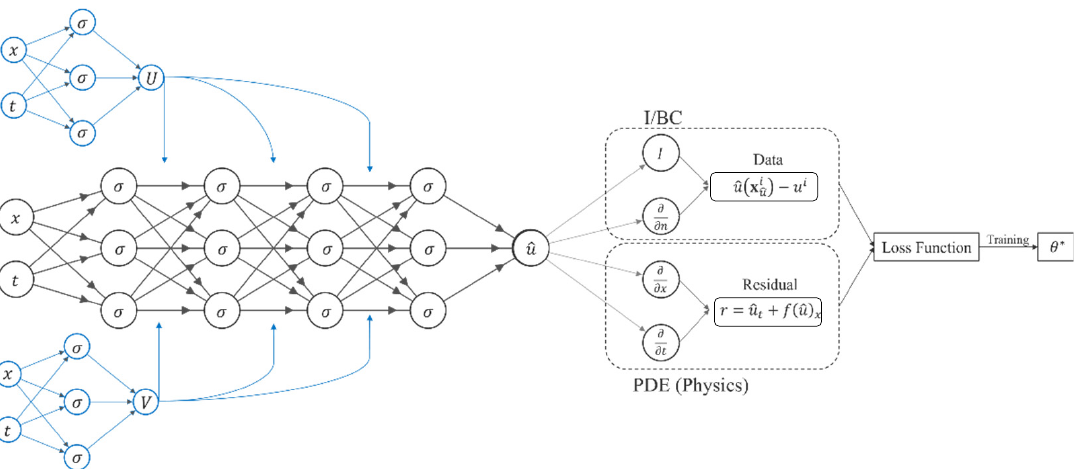
Figure 3. A representative PINN architecture for the solution of the hyperbolic Buckley–Leverett problem. In black is the MLP architecture. In blue is the input encoding of the attention mechanism.